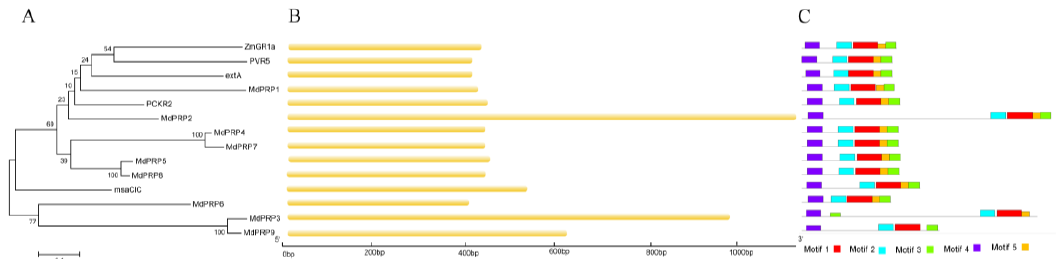
Figure 3. Comprehensive analysis of genes encoding arginine decarboxylase from genomes of M. domestica , A. thaliana (extA, X67421), M. sativamsa (msaCIC, L22305), A. officinalis (PCKR2, X85206), P. vulgaris (PVR5, U34333), and Z. mays (ZmGR1a, AB018587). ( A ) Phylogenetic relationship; phylogenetic tree was constructed using neighbor-joining method. ( B ) Gene structures of PRP; exon-intron analyses of PRP genes were carried out with GSDS. Lengths of exons of each PRP gene are exhibited proportionally, and ( C ) conserved motif of PRP proteins. Conserved motifs in PRP proteins were identified by MEME software. Each motif is indicated by a colored box numbered on the bottom. Length of motifs in each protein is presented